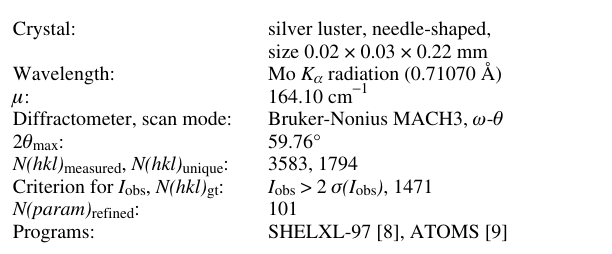
Table 1. Data collection and handling.